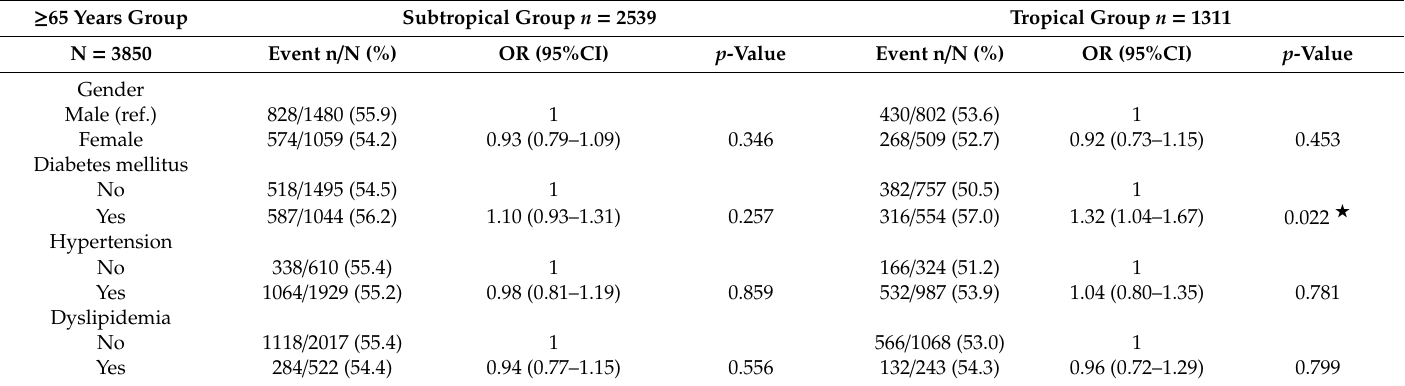
Table 5. The association of the cold season with AMI hospitalization among the ≥ 65 years group and the < 65 years